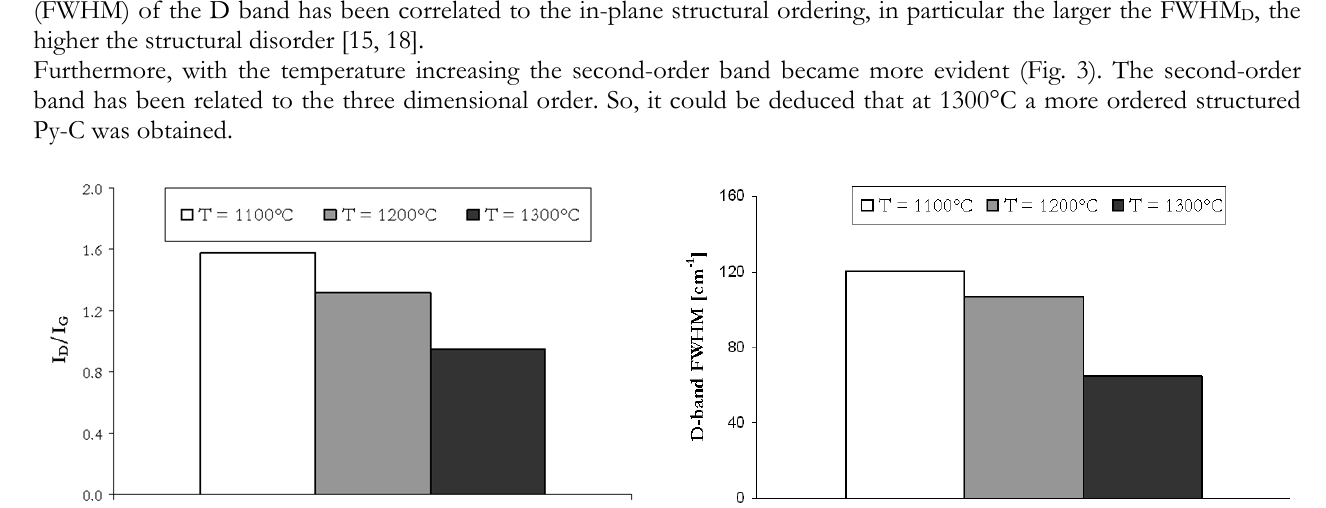
Figure 4: Intensity ratio of D and G bands of Py-C deposited at 1100, 1200 and 1300 °C.